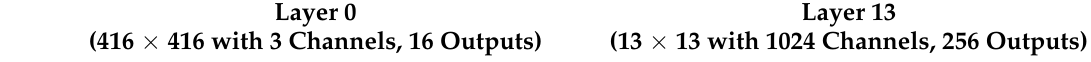
Table 3. Simulation results for the configured parameters. It executes layer 0 and 13 of yolov3-tiny with hardware DLA